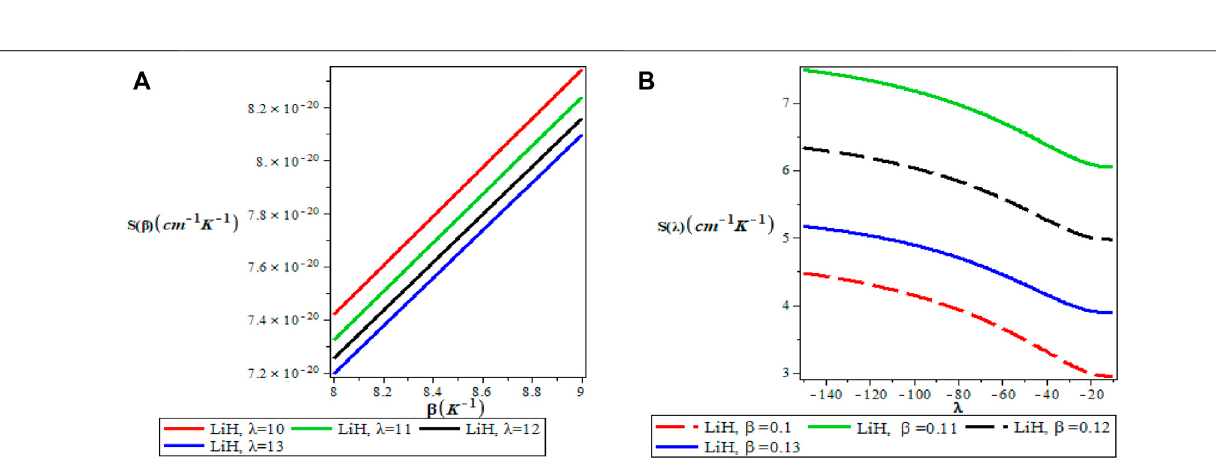
FIGURE 8 | (A) Variation of Vibrational Entropy With Respect to β (B) Variation of Vibrational Entropy With Respect to λ .